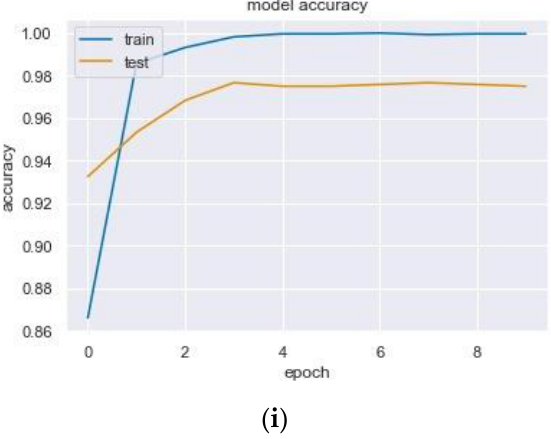
Figure 4. Performance curves of various models for gender classification when trained with facemask images where individuals either wear the mask fully, half, partially, or do not wear one at all (4 ways/styles of wearing). Accuracy curves for ( a ) DenseNet121; ( b ) DenseNet169; ( c ) Xception; ( d ) InceptionV3; ( e ) ResNet50; ( f ) ResNet101; ( g ) VGG16; ( h ) MobileNetV2; ( i ) EfficientNetB0.